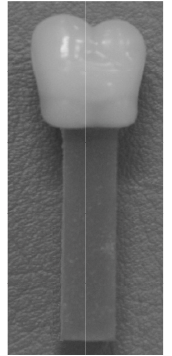
Figure 2. Sample